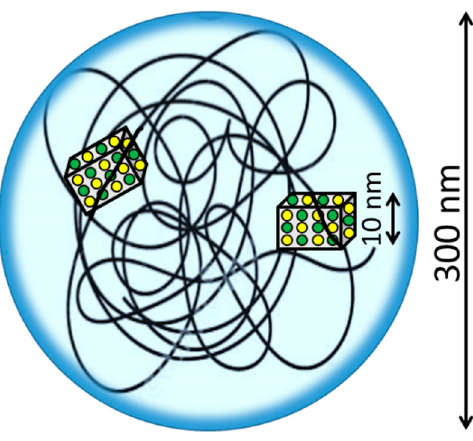
Figure 5. A widely accepted, but unrealistic scheme of gypsum scale inhibition by polyacrylates; yellow and green circles correspond to calcium and sulfate ions, respectively.